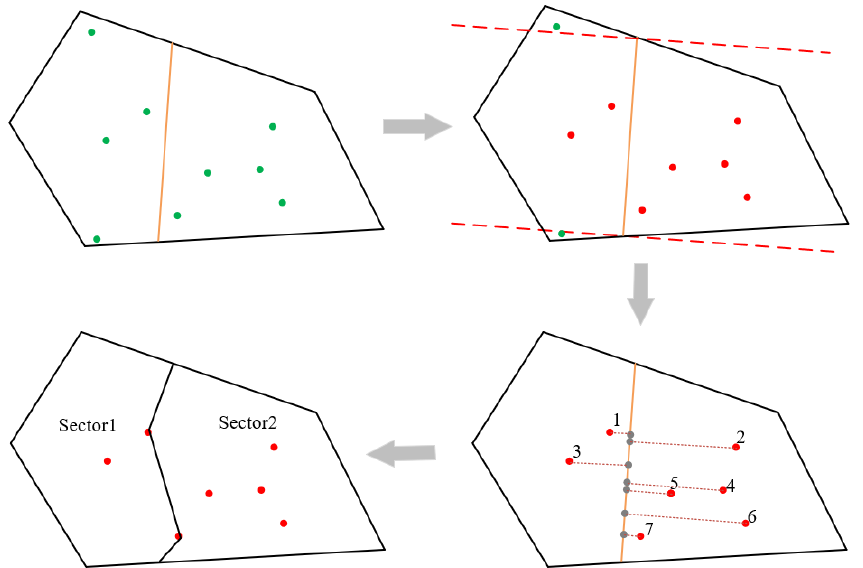
Figure 6. A*-based heuristic algorithm